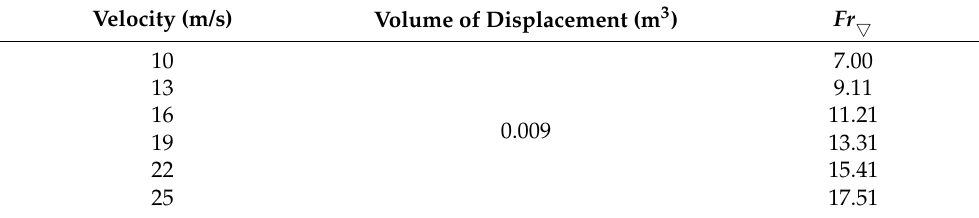
Table 4. Comparison of experimental data and simulation data